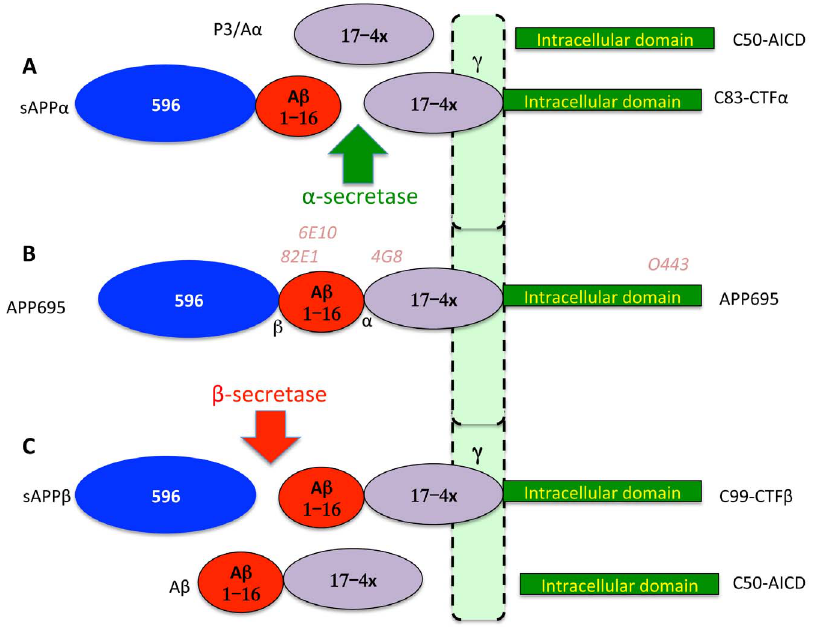
Figure 1. Key APP processing pathways. APP is a type-1 integral-membrane glycoprotein with a large ectodomain a single transmembrane domain and a short intracellular domain (B). While it exists in multiple forms, we are using neuroblastoma cells overexpressing the neuronal 695 aa form. In this form, the ectodomain includes a region of 596 aa that is cleaved and secreted by BACE1 called sAPP b (Blue ellipse) leaving behind the CTF b of 99 aa (C). The A b sequence starts with the first 16 aa, which is released with the 596 aa after cleavage by a -secretase to sAPP a of 612 aa, and CTF a of 83 aa (A). The presenilin-containing multisubunit c -secretase cleaves CTF a (A) and CTF b (C) to secreted proteins of 3 kDa (A a ) and 4 kDa (A b ), respectively. Although multiple intramembrane intermediate forms of A b and P3 are reported, the major secreted forms terminate at residue 40 followed at much lower levels by residue 42 of the A b sequence. Numerous studies have demonstrated that most FAD mutations preferentially increase A b 42. Antibodies used in the study are indicated above the APP schematic (B). Domains of APP are not drawn to scale but colors are consistent in all figures. Note that we are using A a instead of the more common P3 or A b 17–40/42 to maintain processing pathway consistency that makes it easier for the